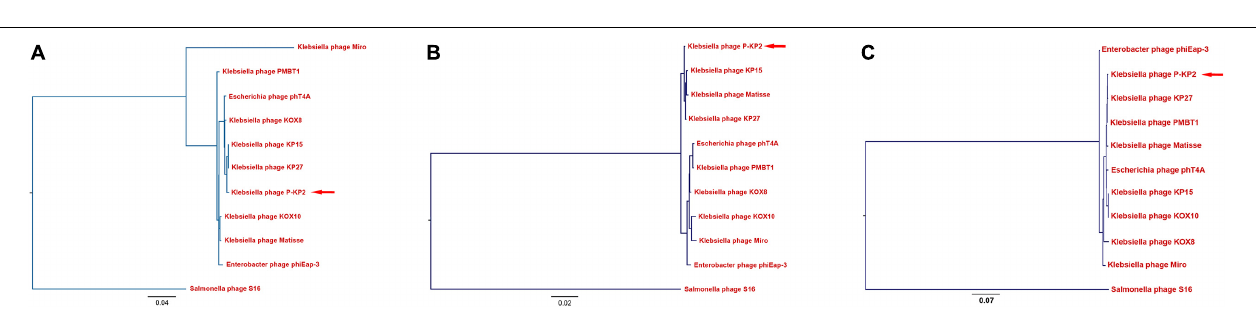
FIGURE 3 | Multiple genome alignments among P-KP2 and homologous phages. The graph was generated by Mauve software. To present the average conservation level in the genome sequence, the similarity of regions is indicated by the height of the bars. Fragment that are not aligned or specific to a particular genome are represented by white areas. Regions of homologous DNA shared by two or more genomes are defined as a local collinear blocks (LCBs), represented by boxes with the identical colors.